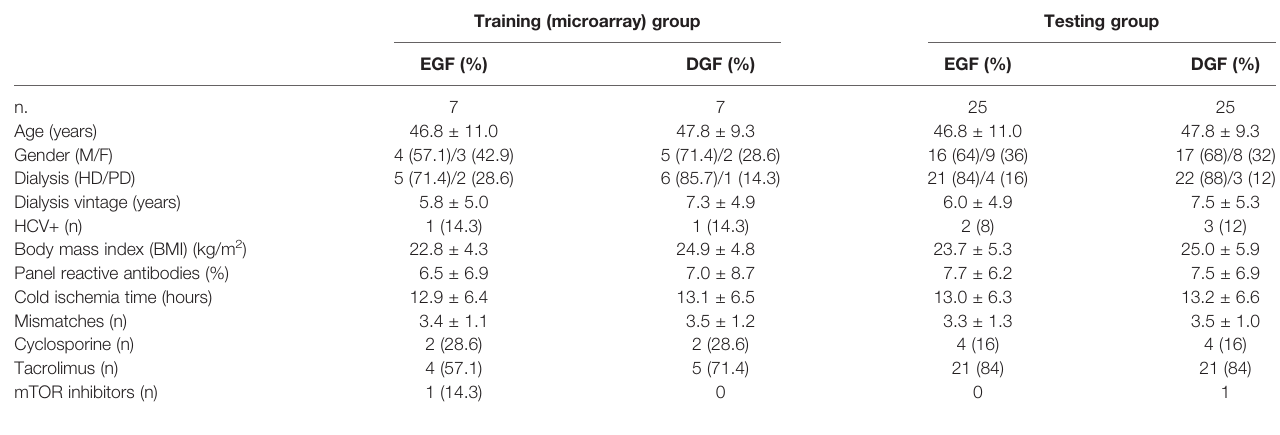
TABLE 2 | The main demographic and clinical characteristics of patients included in the microarray group and in the testing group. Training (microarray) group Testing group EGF (%) DGF (%) EGF (%) DGF (%) n.